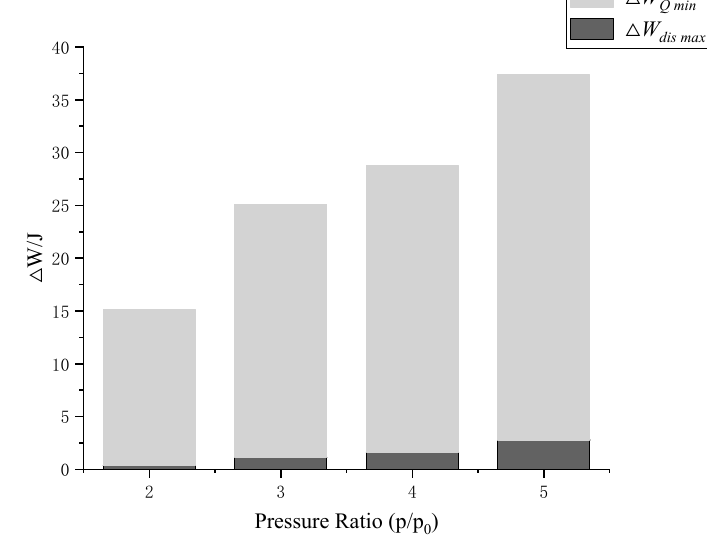
Figure 13. Reduction of compression work.